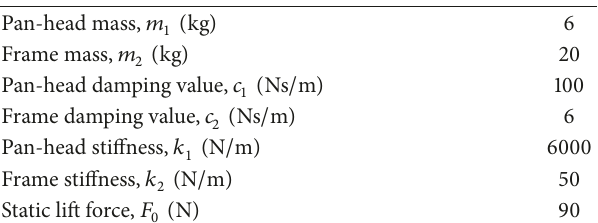
Table 5: Parameters of the pantograph SS7.